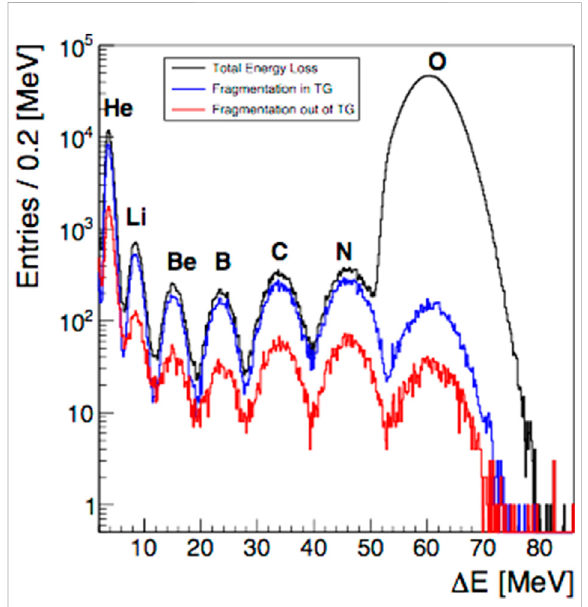
FIGURE 11 Energy loss distribution for the fragments reconstructed by the TW detector (black), primary fragmentation coming from the TG in the TW acceptance (blue) and primary fragmentation out of TGimpingingonTW(red).AfullMCsimulationhasbeenused to disentangle the different contributions.